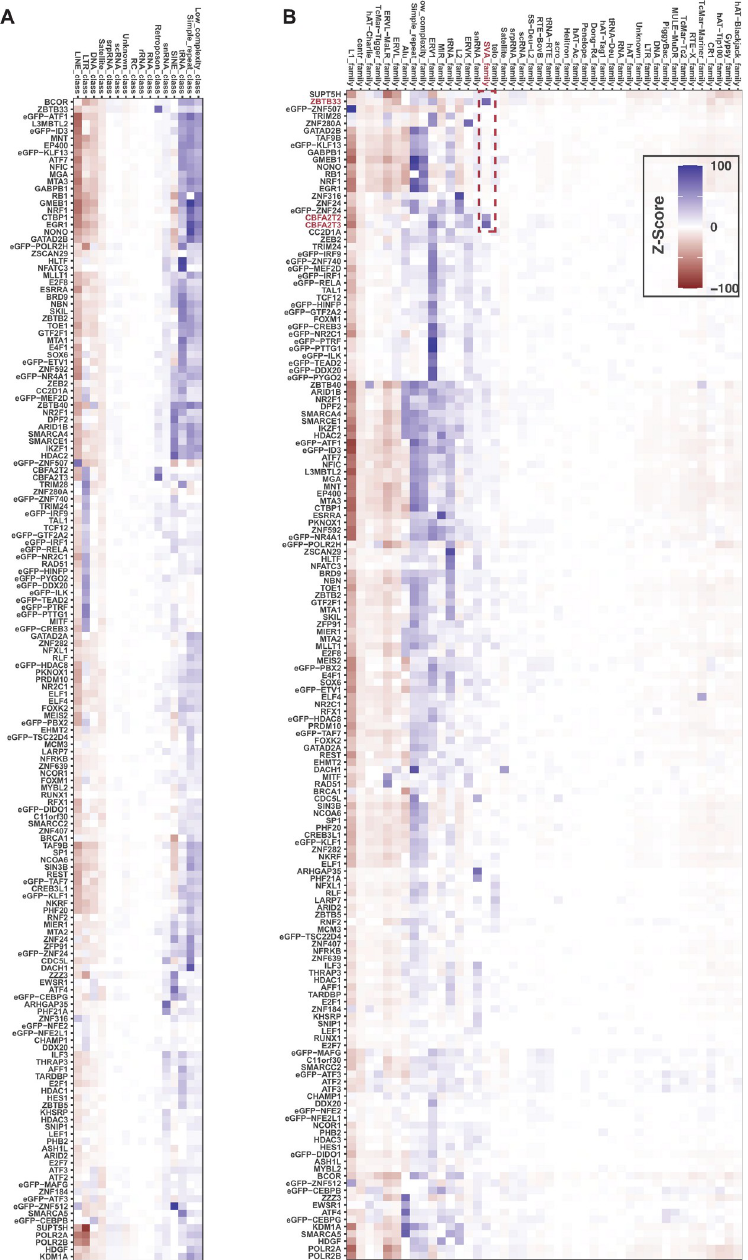
Fig 4. Many DBPs are enriched or depleted on repeat classes and families. (A) Heat map of Z-scores of observed overlaps of each DBP versus the overlap distribution of 1,000 random permutations of each DBPs profile genome wide. Red indicates depletion and blue enrichment (negative versus positive Z-scores respectively). The observed and permuted Z-scores are for overlaps with repeat classes. (B) The same permutation analysis as in (A), but for observed versus permuted overlaps with repeat families. Red indicates depletion and blue